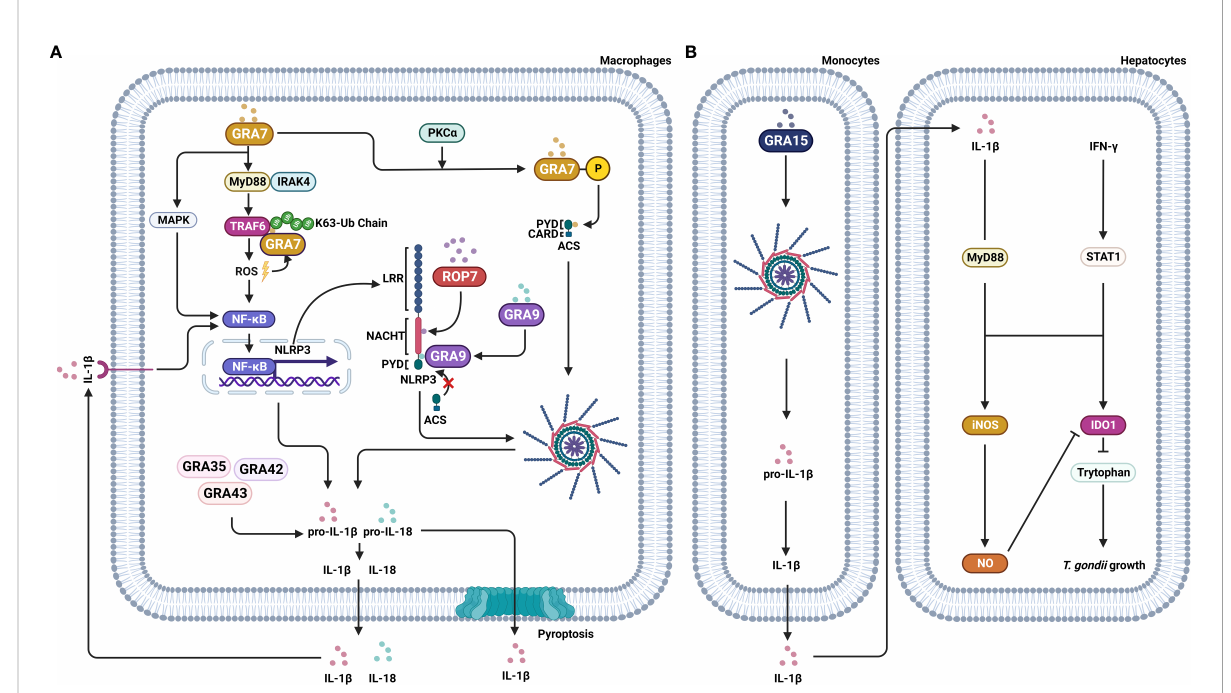
FIGURE 1 Effector proteins of T. gondii manipulate signaling pathways of the host cell. T. gondii secrets effector proteins, including ROP and GRA, into the host cell to in fl uence the signaling pathways of the host. (A) ROP7 of T. gondii interacts with the NACHT domain of NLRP3 and assembles the NLRP3 in fl ammasome, leading to IL-1 b secretion, which in turn induces an NF- k B/NLRP3-positive loop. GRA7 induces the expression of proin fl ammatory cytokine IL-1 b through MyD88-dependent ROS generation and TRAF6 activation. GRA7, after PKC a -mediated phosphorylation, interacts with the PYD domain of ACS, inducing ASC oligomerization and in fl ammasome activation. GRA35, GRA42, and GRA43, induce pyroptosis and IL-1 b secretion. In contrast, GRA9 binds with NLRP3, which results in blocking the interaction between ASC and NLRP3 and, in turn, the disrupting of the NLRP3 in fl ammasome assembly. (B) GRA15 induces IL-1 b secretion through the NLRP3 in fl ammasome. Secreted IL-1 b and IFN- g induce iNOS expression and NO production, resulting in the reduction of IDO1 expression and contributing to T. gondii growth in